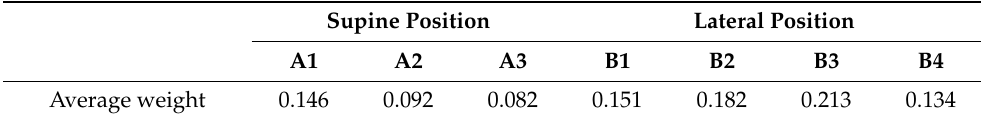
Table 5. Weight of compressive coefficients in each partition.